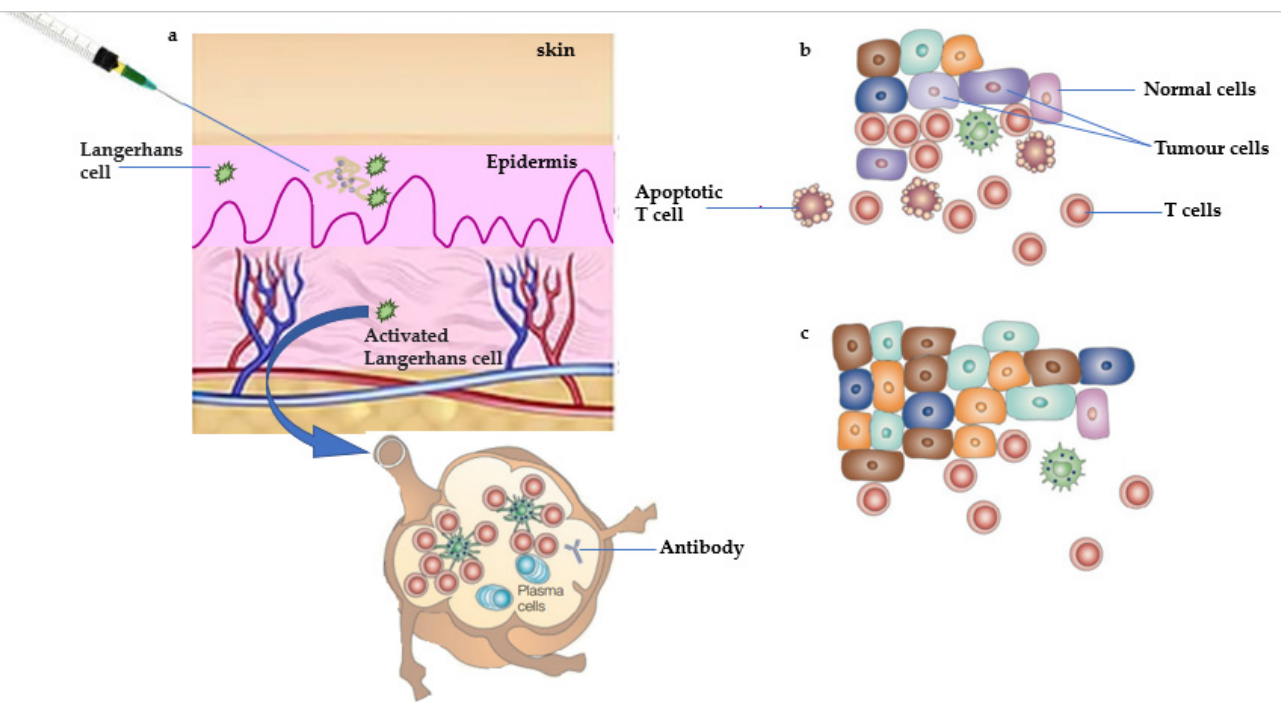
Figure 1 . Manipulation of antitumor immune responses by therapeutic vaccination . ( a ) Therapeutic vaccines are administered after the tumor is diagnosed, at the time of interactions between the tumor and the immune system that correspond to part c . Therapeutic vaccines boost immunity against minimal residual disease and prevent the outgrowth of metastases shown in parts b and c . A vaccine based on an autologous tumor was administered in an immunostimulatory preparation ( with adjuvant ) that can activate Langerhans cells — dendritic cells ( DCs ) that reside in the epidermis . Activated Langerhans cells take up the tumor antigens and traffic to the draining lymph node in which they present antigens to T - cells . B - cells are also activated, and the expected outcome is clonal expansion of tumor - specific T - cells and the production of tumor - specific antibodies . ( b ) Tumor - specific T - cells migrate to the sites of tumor metastases where they attempt to kill tumor cells that express antigens contained in the vaccine . ( c ) Metastases that continue to grow are composed of tumor cells that lack antigens recognized by T - cells and antibodies or are otherwise resistant to immune destruction .